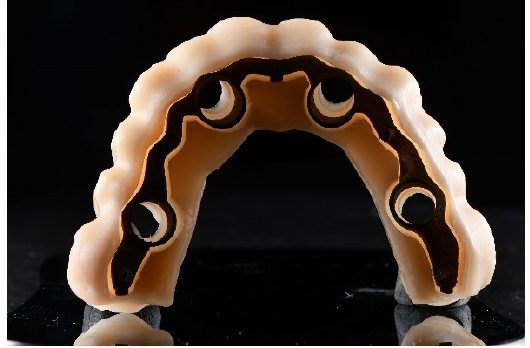
8 Figure 8. Multi-piece surgical template. From left to right: base-, implant-, and index-portion. The base portion allows for template stabilization, bone reduction, and temporary restoration delivery; the implant portion allows for guided implant placement; and the index portion allows for template stabilization in centric relation, before surgery. All of the implants were placed using guided surgery, but in two different surgical sections, two months apart. In both jaws, anesthesia (4% articaine with adrenaline 1/100,000, Septanest, Septodont, Mataró, España) was made in the buccal area and thought the holes of the surgical templates, about 15 min before surgery. After that, a muco- periosteal flap was done.